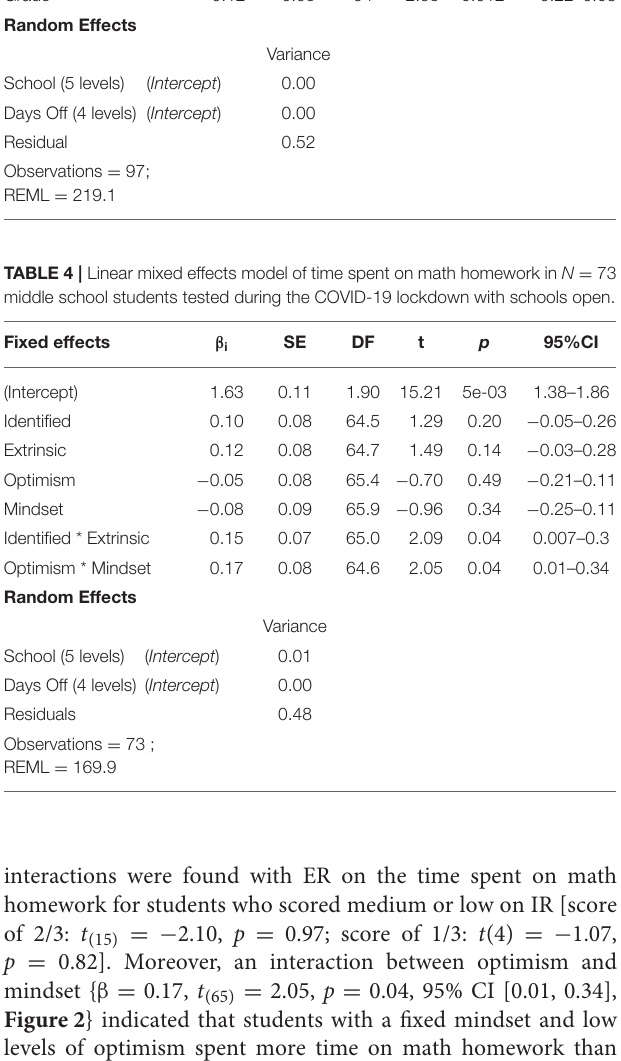
Figure 2 } indicated that students with a fixed mindset and